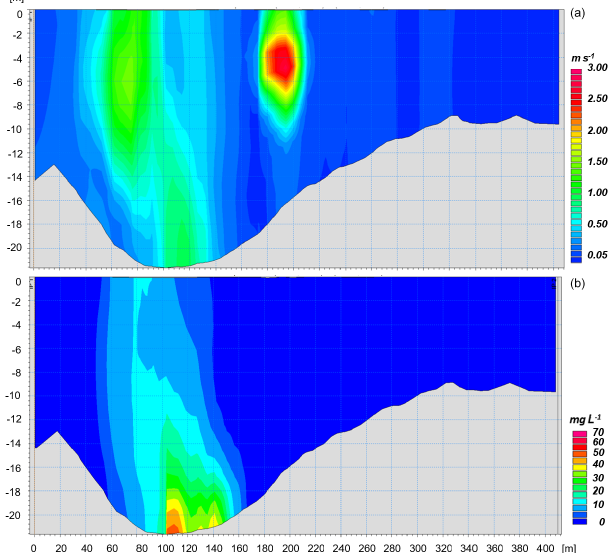
Figure 10. (a) Velocity intensity (in ms − 1 ) and (b) sediment con- centration (in mgL − 1 ) along the transect from the head of Ponte Assereto to the head of Ponte dei Mille.